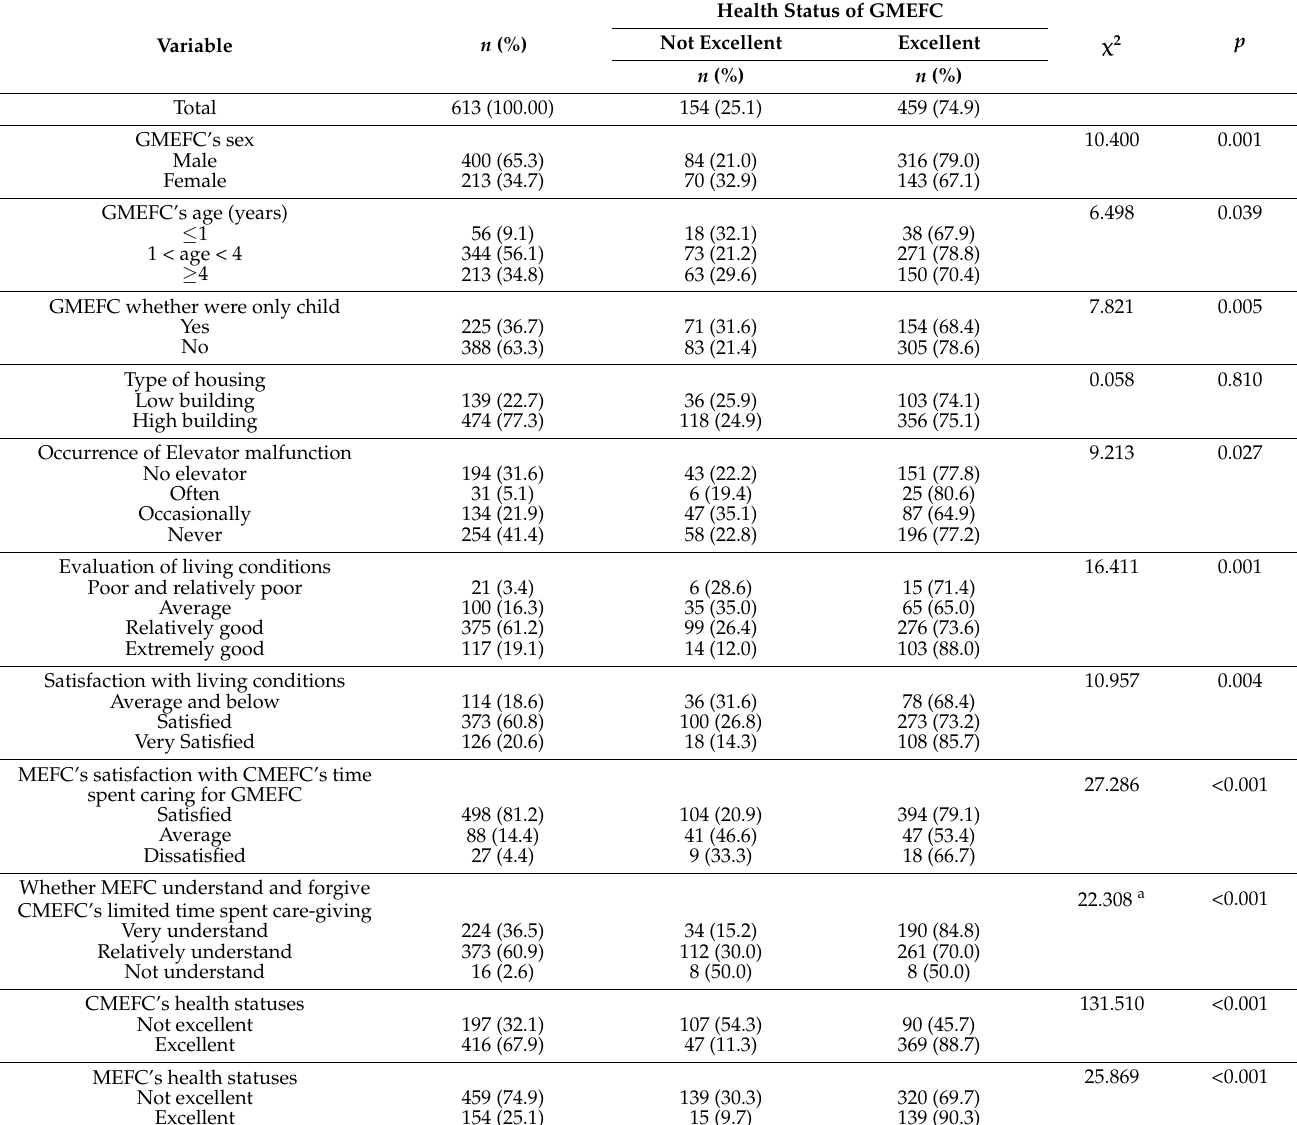
Table 1. Descriptive analysis of the health statuses of GMEFC in Weifang,